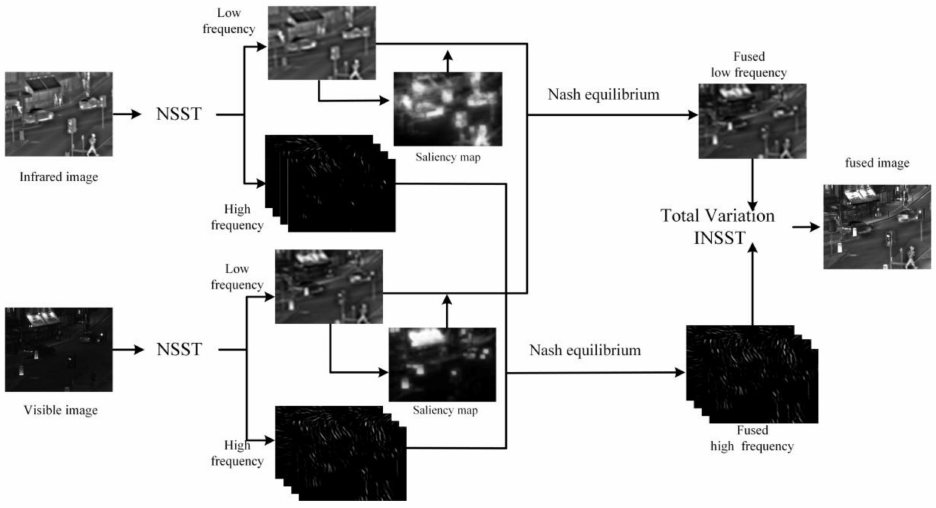
Figure 3. The illustration of the proposed